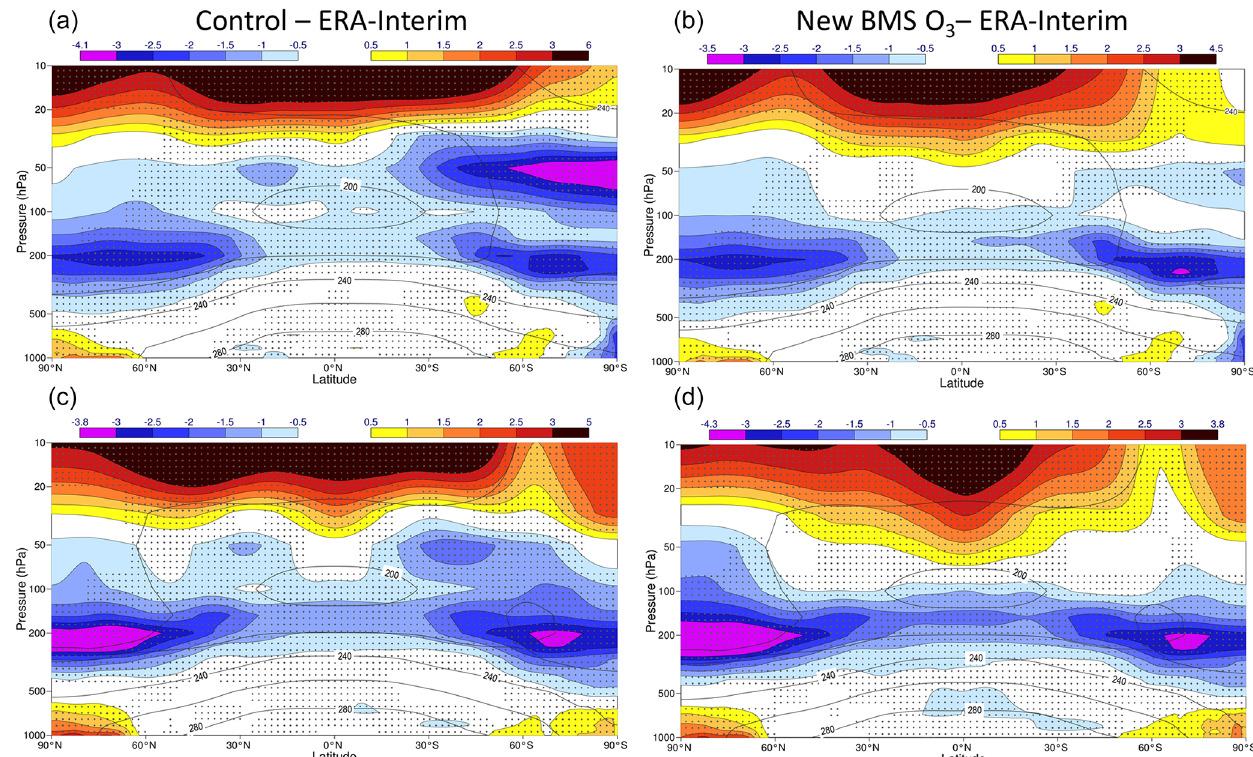
Figure 14. Zonal average of temperature differences compared to ERA-Interim for two long-range model experiments, one with the default model configuration in which the radiation scheme sees the ozone climatology (a, c) and another one in which the new ozone scheme is used and made interactive with radiation (b, d) . Panels (a) and (b) show DJF differences, and panels (c) and (d) show MAM differences. The period covered is 1981–2010, and the model version used is Cy41r1 with a horizontal resolution T255 and 91 vertical levels up to 0.01hPa. Dotted areas indicate regions in which the differences are statistically significant at the 95% confidence level.